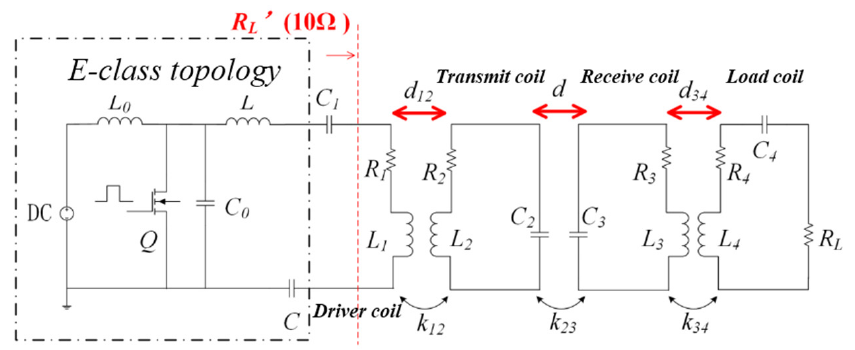
Figure 1. Wireless power transfer circuit topology.